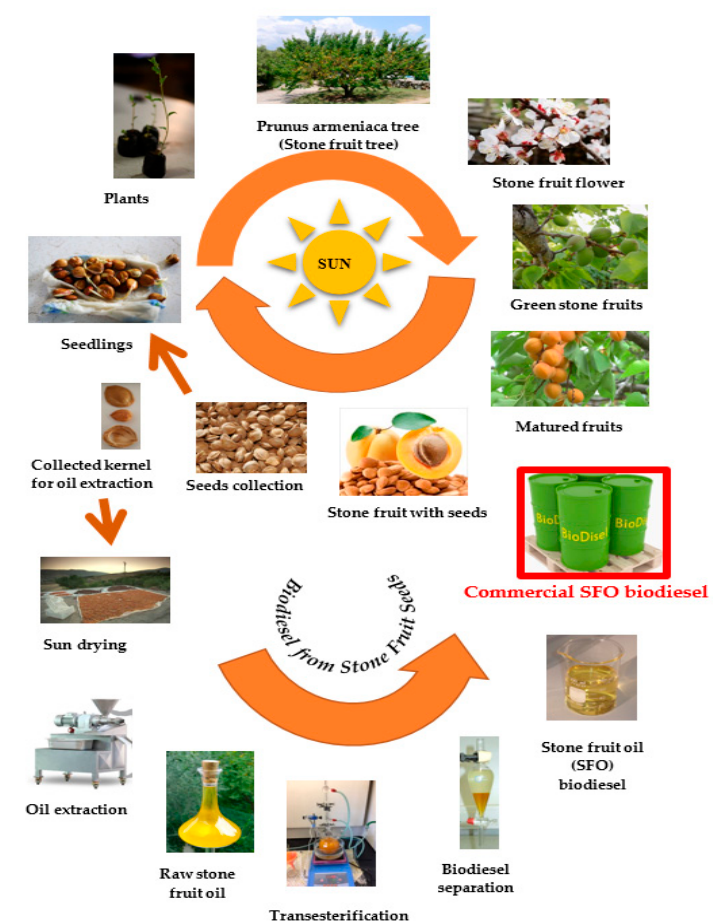
Figure 1. Graphical representation of producing biodiesel from SFO biodiesel.